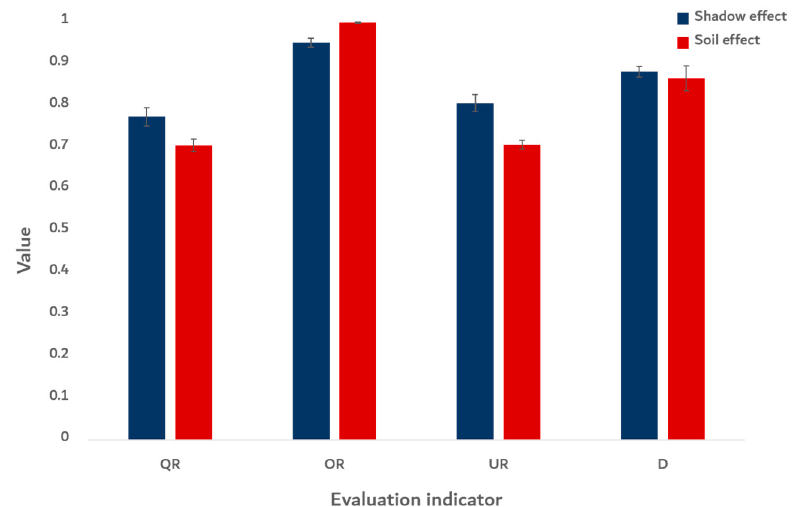
Figure 13. Evaluation results of different effect factors. The color column is the average value, and the black line means the error line. The QR, OR, UR, and D represent the evaluation indicators of the segmentation results under the influence of shadow and soil effect, respectively.